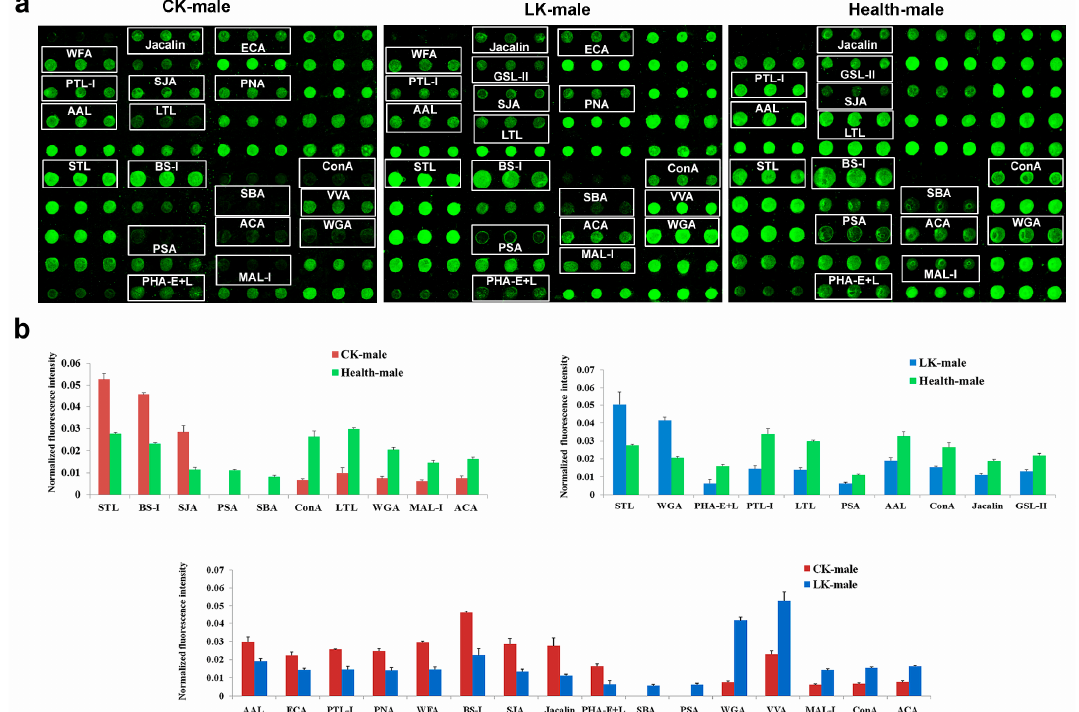
Figure 1. Male salivary glycoprotein glycosylation patterns were determined by the binding of Cy3-labeled protein to 37 different lectins using a lectin microarray. CK: CKD, LK: LKD and Health: normal control. ( a ) Profiles of Cy3-labeled salivary proteins from patients with CKD, LKD, and normal control individuals bound to the lectin microarrays. The lectins, which exhibited remarkable differences in the staining intensity are marked with white frames; ( b ) Comparisons of the lectin-binding levels between the three groups. The bars represent mean ± SD measured from three replicate spots of lectins.